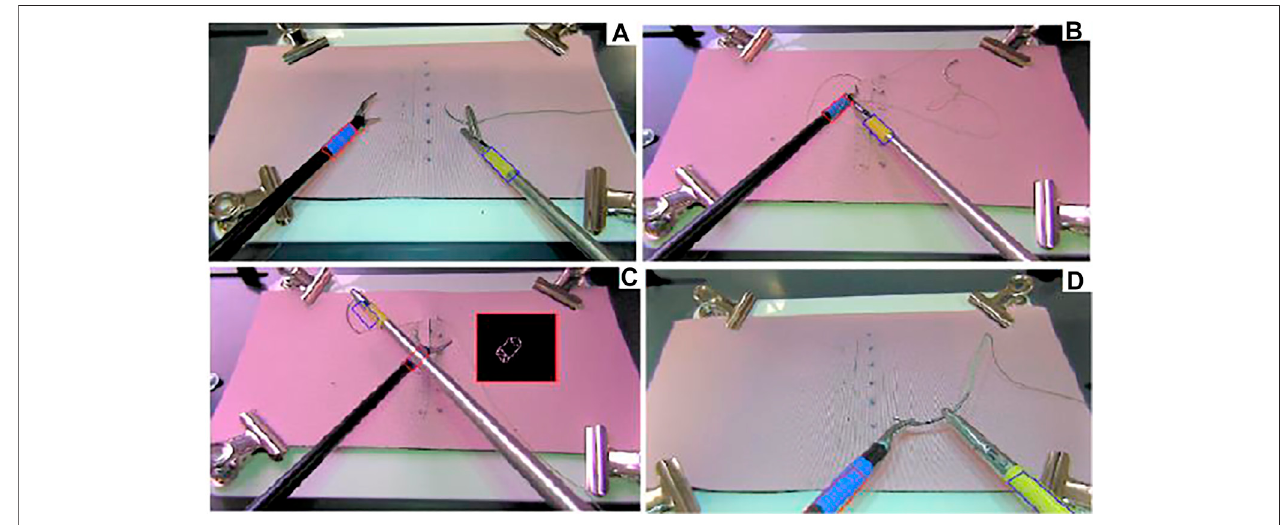
FIGURE1|(A) Instrumentdetection, (B) convexHullareawhentheropeiscrossingthebluemarker, (C) convexHullareawhentheinstrumentiscrossingtheblue marker and obscuring the marker, (D) out of the fi eld of view, when Kalman fi lter prediction is used (Gautier et al., 2019).